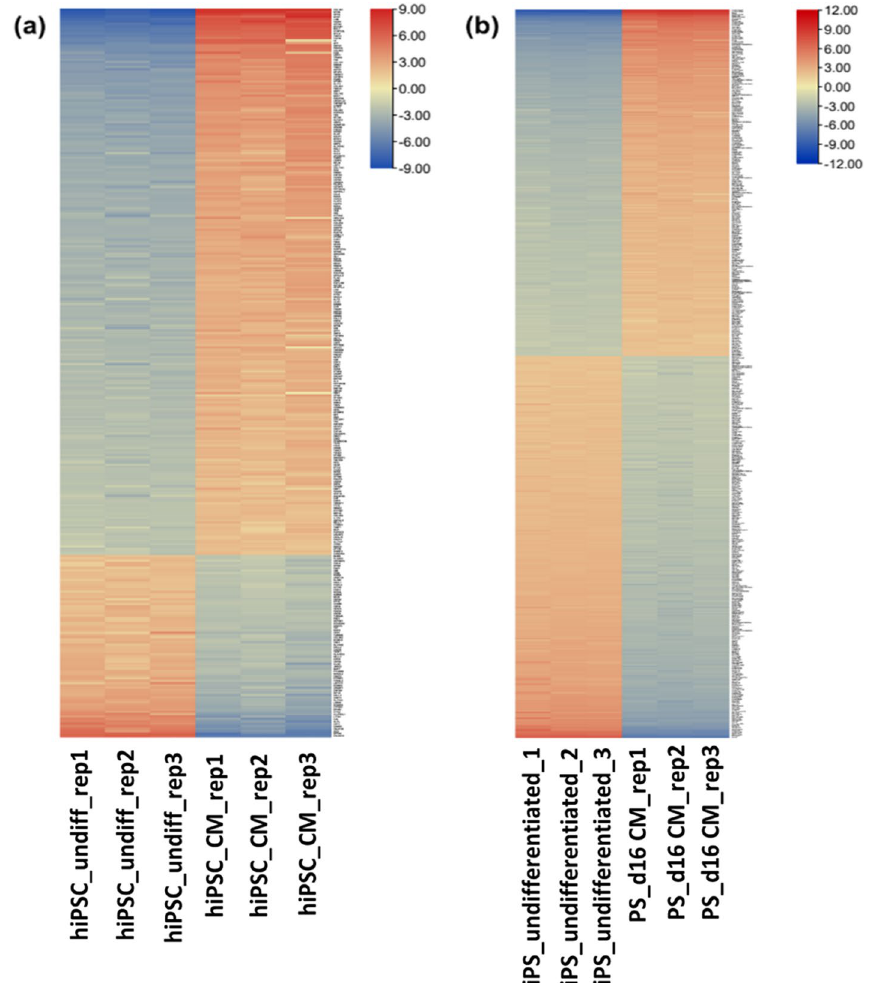
Fig. 2 Heatmaps- Heatmaps which show hierarchical clustering analysis results of the DEGs from both the mouse and human data matrices and show those genes which are significant at a threshold of a log2 fold change of 2.0. Each column represents a sample, and each row represents a DEG. Blue shows a lower value for gene expression while red shows a higher value for gene expression. a the human data set, GSE17579. b mouse data set,